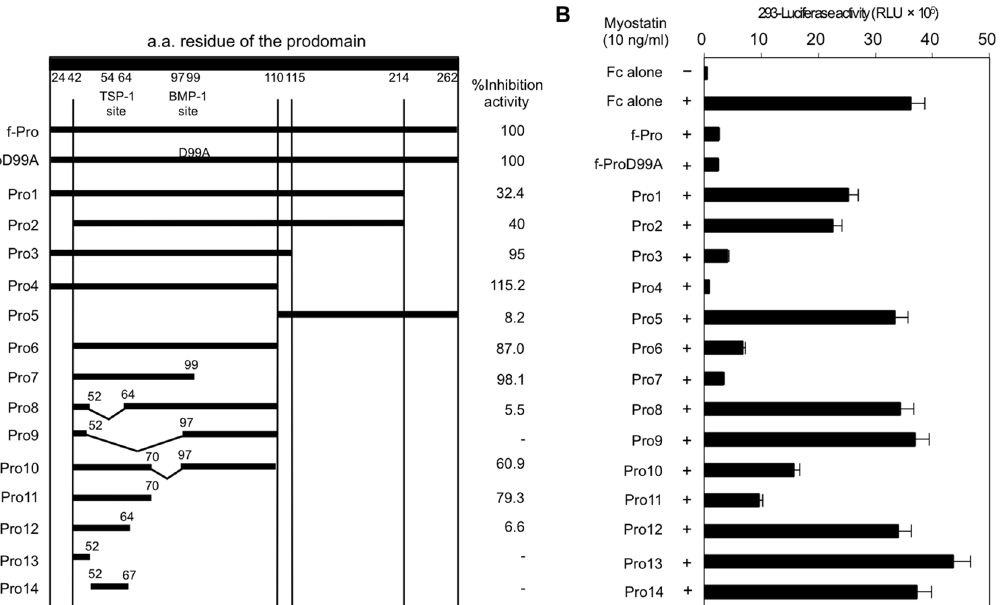
Fig 1. Identification of the inhibitory core of the myostatin prodomain. ( A ) Truncation and deletion constructs of human myostatin prodomain:human Fc fusion proteins ( left ). Percentage inhibitory effect of each construct on myostatin activity in comparison with the full-length prodomain (f-Pro, right ). ( B ) Recombinant myostatin-induced transcriptional activity in HEK293 human embryonic kidney cells co-transfected with a pGL3-(CAGA) 12 -luciferase reporter gene, pCMV- β -Gal, and various prodomain region:Fc fusion constructs. Values are the mean ± SD ( n = 6). RLU, relative luminescence